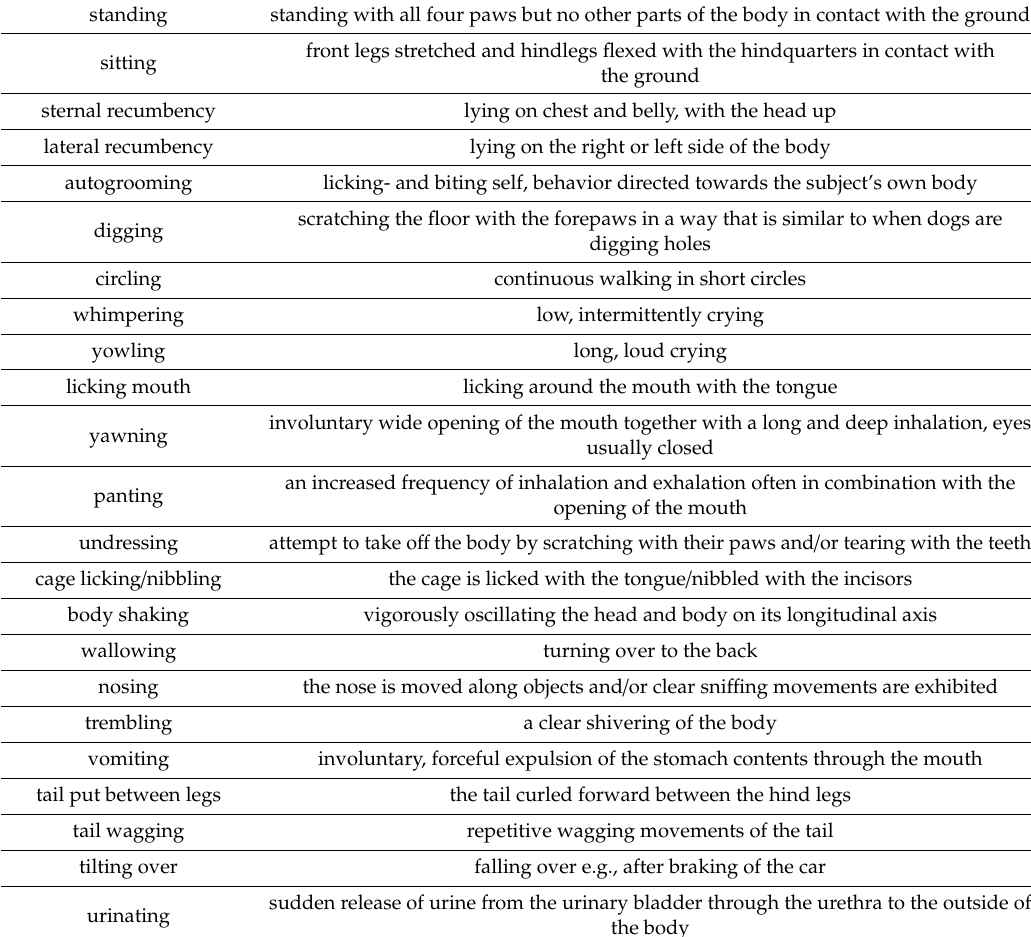
Table 3. Behavioral patterns analyzed during transport and control phases in the stationary